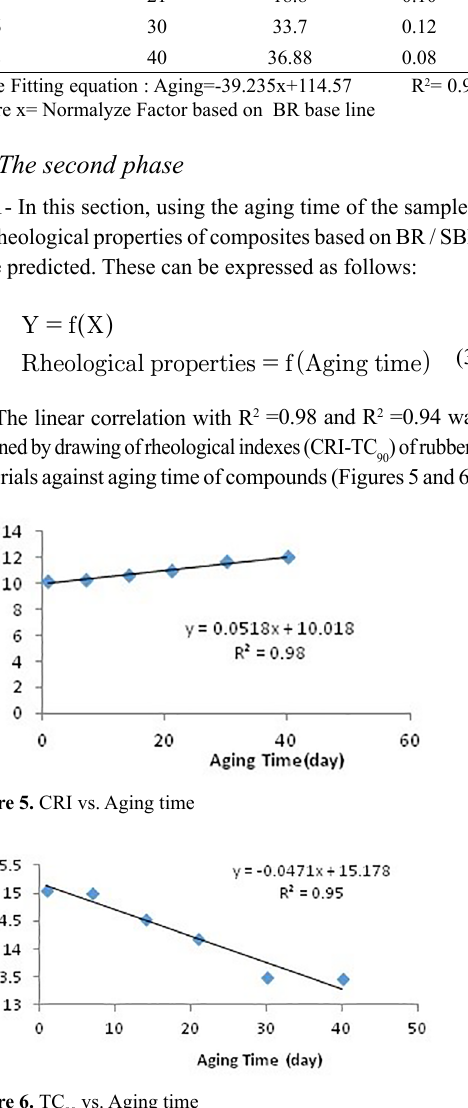
vs. Aging Figure 6. TC 90